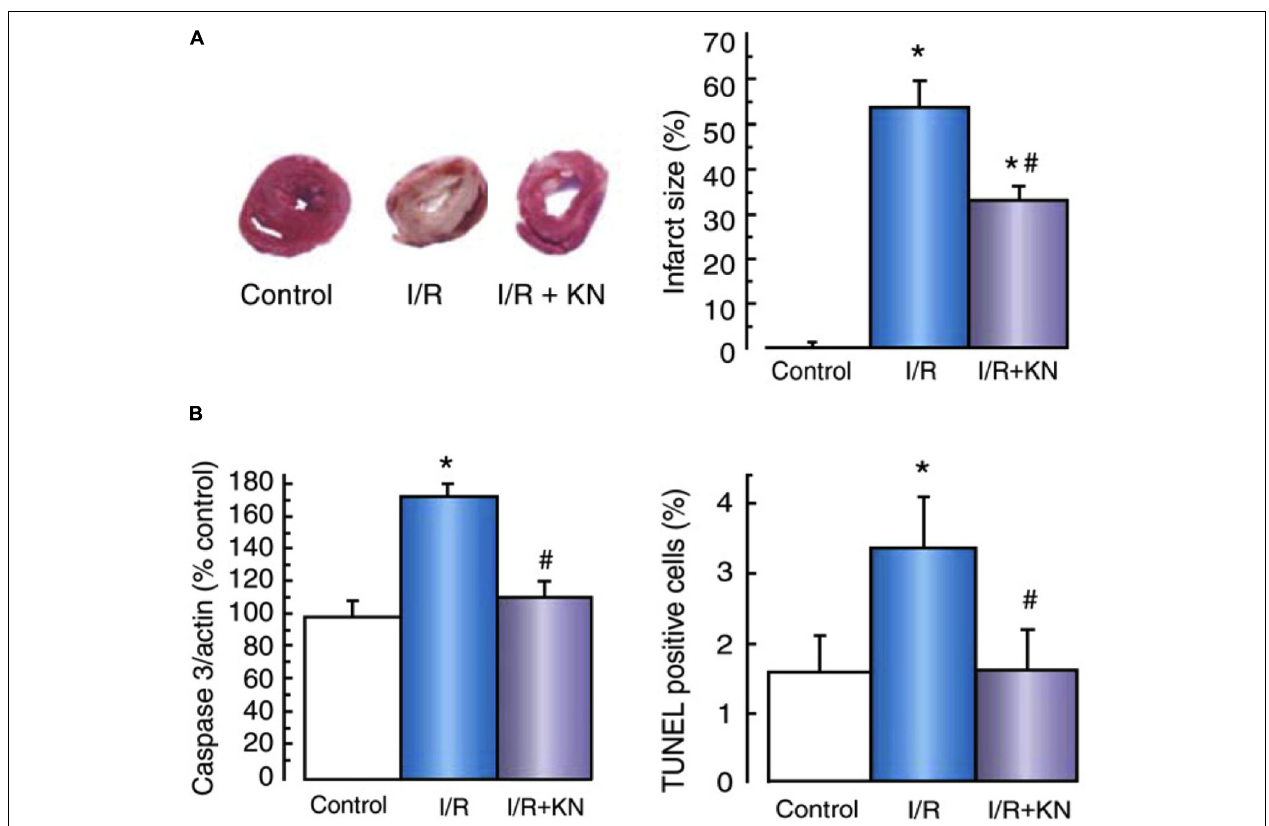
FIGURE 3 | Cell death in ischemia/reperfusion was suppressed by CaMKII inhibition. (A) Assessment of TTC stained heart cross-sections showed KN93 significantly reduced infarct size in ischemia/reperfusion. (B) Lower caspase 3 activation and less TUNEL positive cells in these